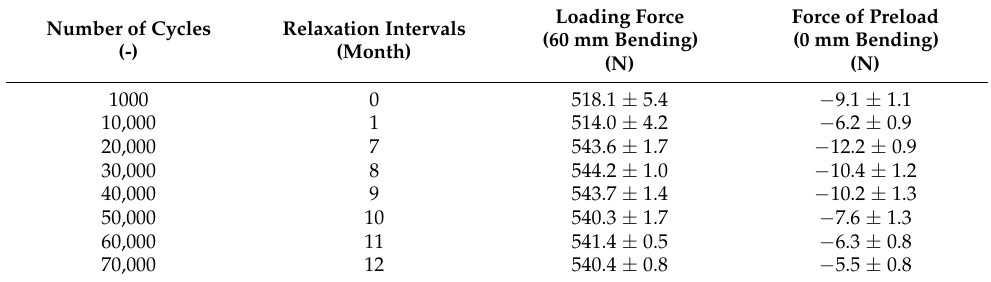
Table 3. Test parameters and results low-cycle test of hybrid sandwich ski construction. Number of Cycles